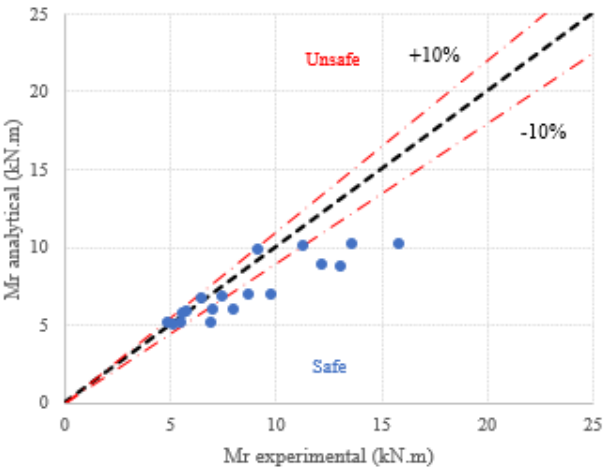
Figure 7. Post-fire moment capacity: analytical vs.